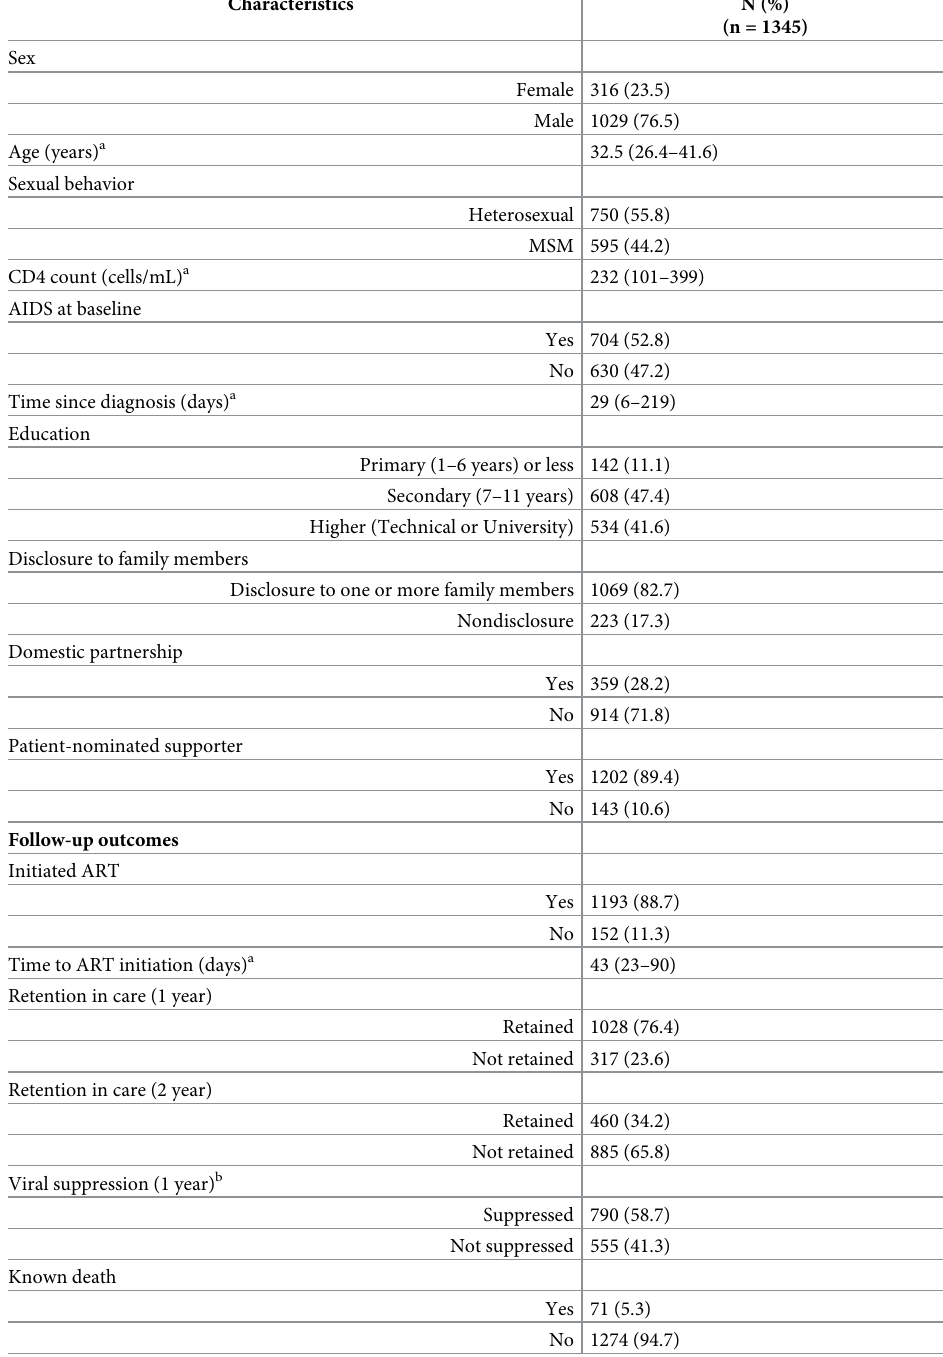
Table 1. Characteristics and outcomes of people living with HIV who were evaluated by a social worker, 2011–